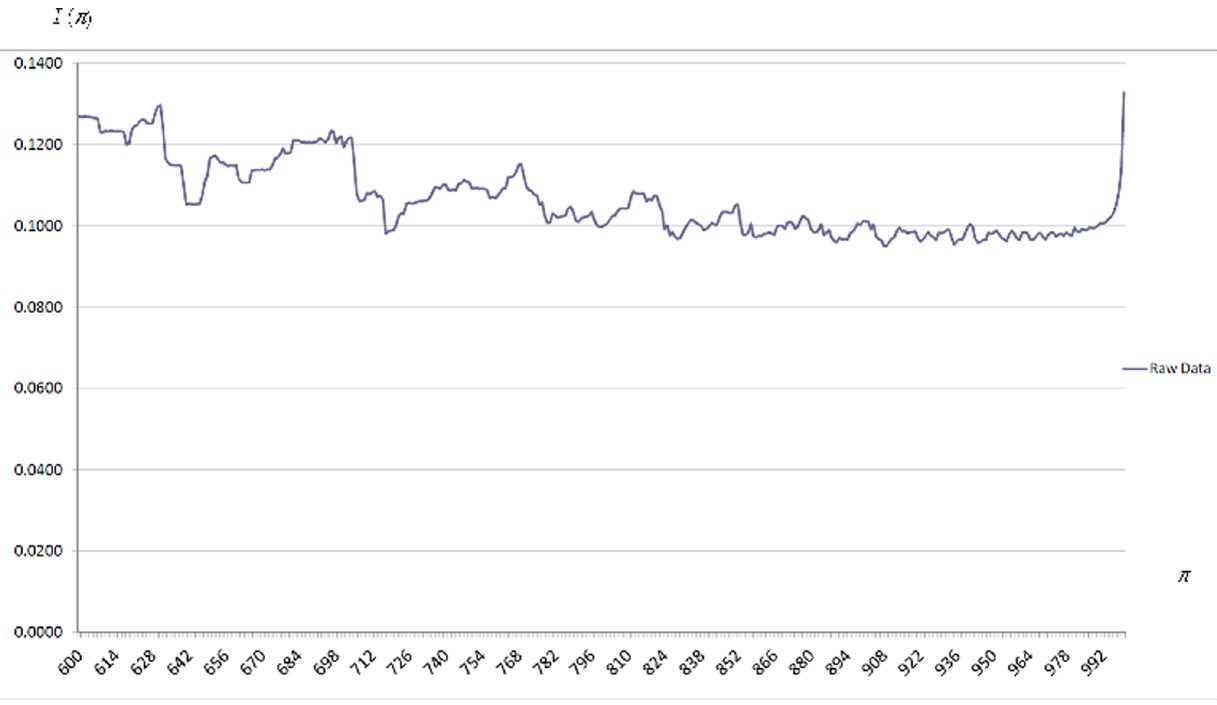
Figure 1. Citation Inequality Due to Differences in Citation Practices, I ( p ) , as a function of p . Raw data. Results for the ½ 600,1000 (cid:2) quantile interval.